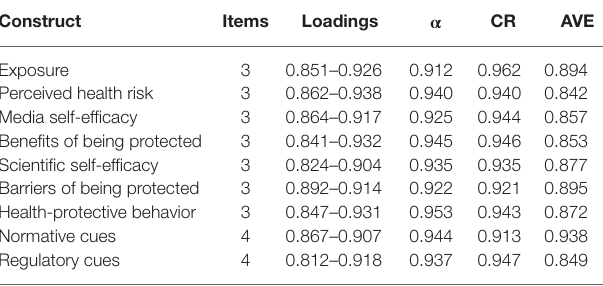
TABLE 2 | Internal reliability testing for the OVERALL collected